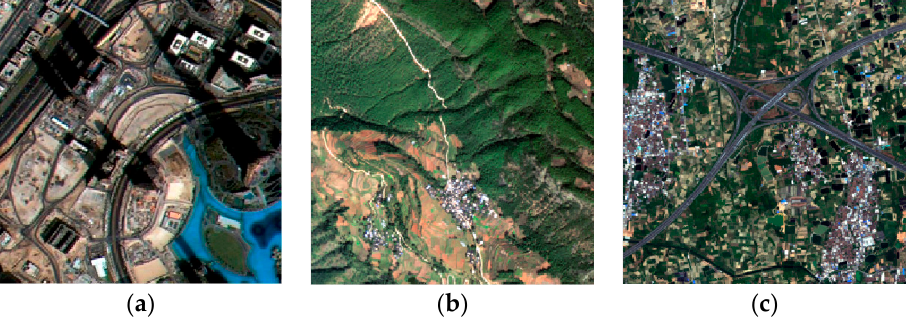
Figure 5. Simulation multi-temporal image ( a ) ZY-3 multi-temporal image; ( b ) GF-2 multi-temporal image; ( c ) WorldView-2 multi-temporal image.